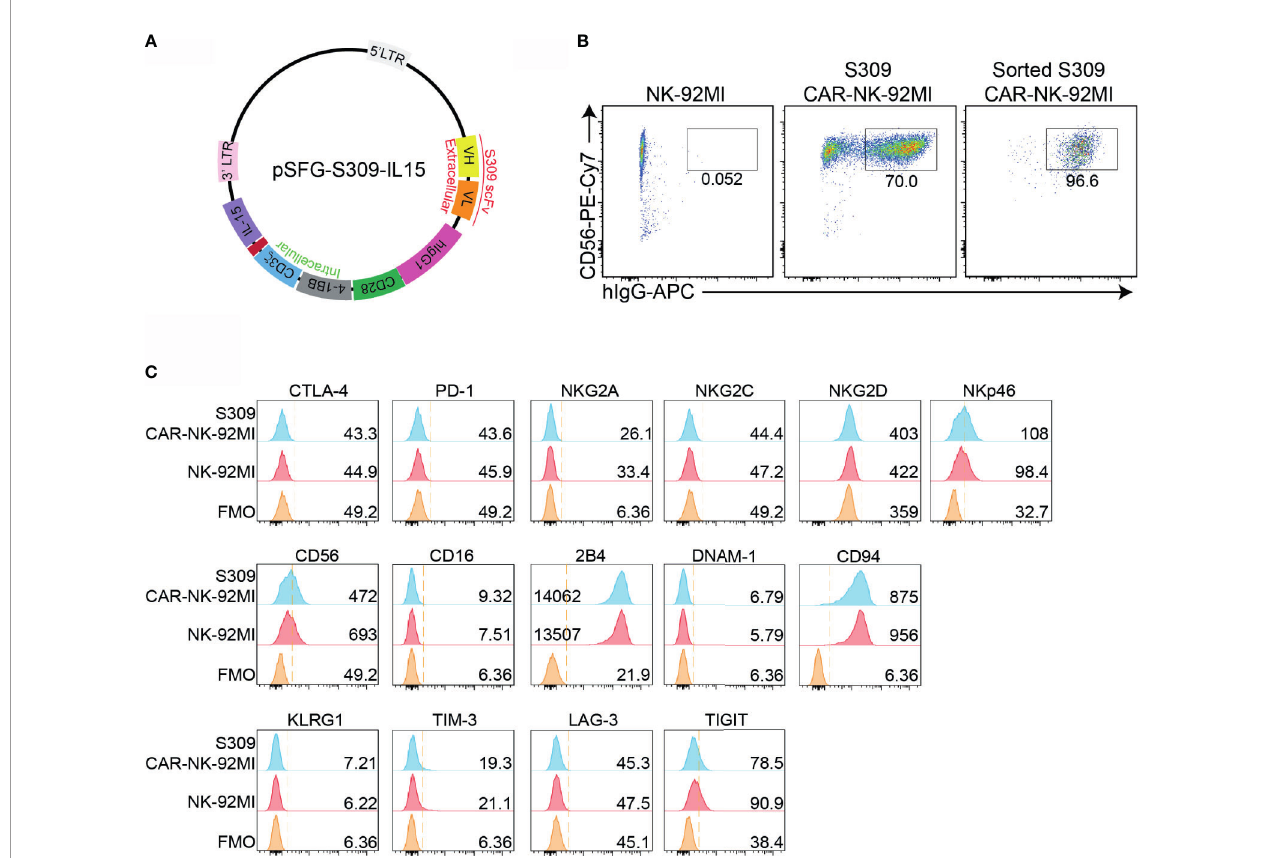
FIGURE 1 | Generation of S309-CAR-NK-92MI cells. (A) Plasmid construct of S309-CAR. The SFG retroviral vector contains the S309 single chain antibody fragment (accession code 6WS6 on PDB), a human IgG1 CH2CH3 hinge region, a CD28 transmembrane region, followed by the co-stimulatory CD28, 4-1BB, and the intracellular domain of CD3 z . (B) Determination of S309-CAR-NK expression by fl ow cytometry. S309-CAR cells were collected and stained with anti-CD56 and CAR F(ab)2 domain [IgG (H+L)] for fl ow cytometry. The cells were then sorted to achieve a homogenous population of high CAR expression. (C) Representative histogram showing the immunopro fi ling of S309-CAR-NK-92MI cells by fl ow cytometry. S309-CAR-NK-92MI or the wildtype (WT) NK-92MI cells were stained with antibodies against different immunomodulatory receptors including CTLA-4, PD-1, NKG2A, NKG2C, NKG2D, NKp46, CD56, CD16, 2B4, DNAM-1, CD94, KLRG1, TIM-3, LAG-3, and